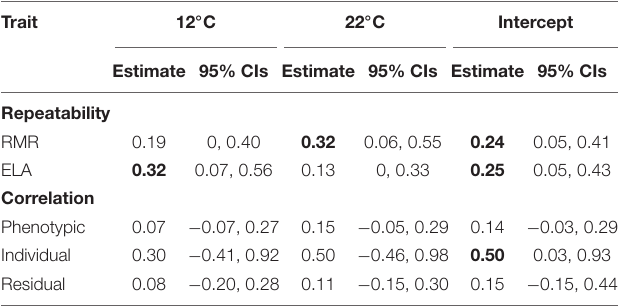
TABLE 2 | Repeatability of resting metabolic rate (RMR) and exploratory locomotor activity (ELA) and their correlation coefficients measured at two body